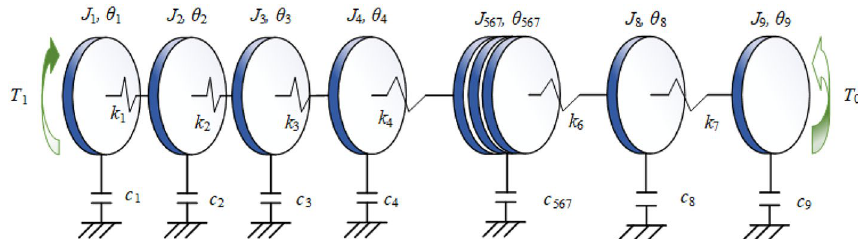
Figure 3 Dynamic model in sticking